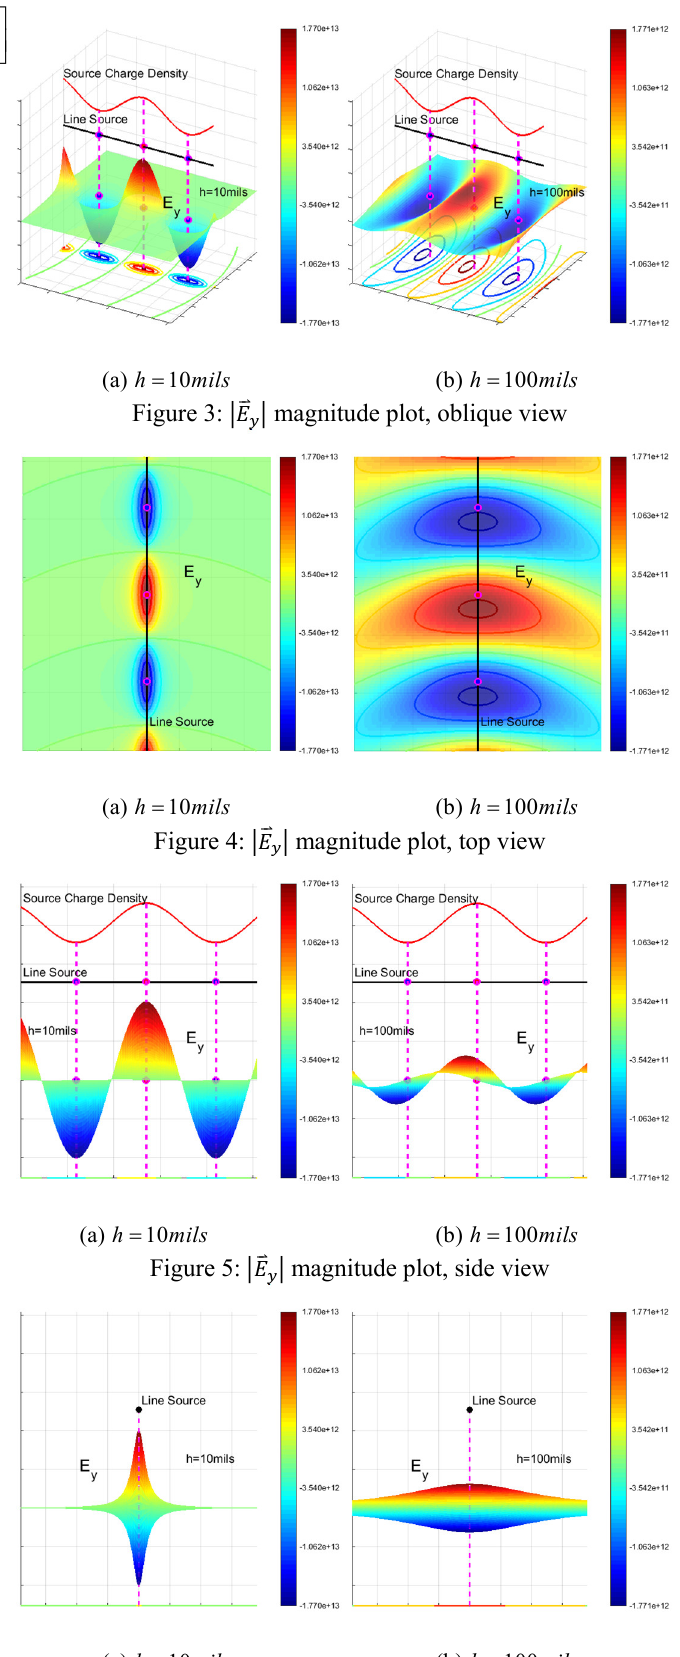
Figure 6: ⃑ magnitude plot, front